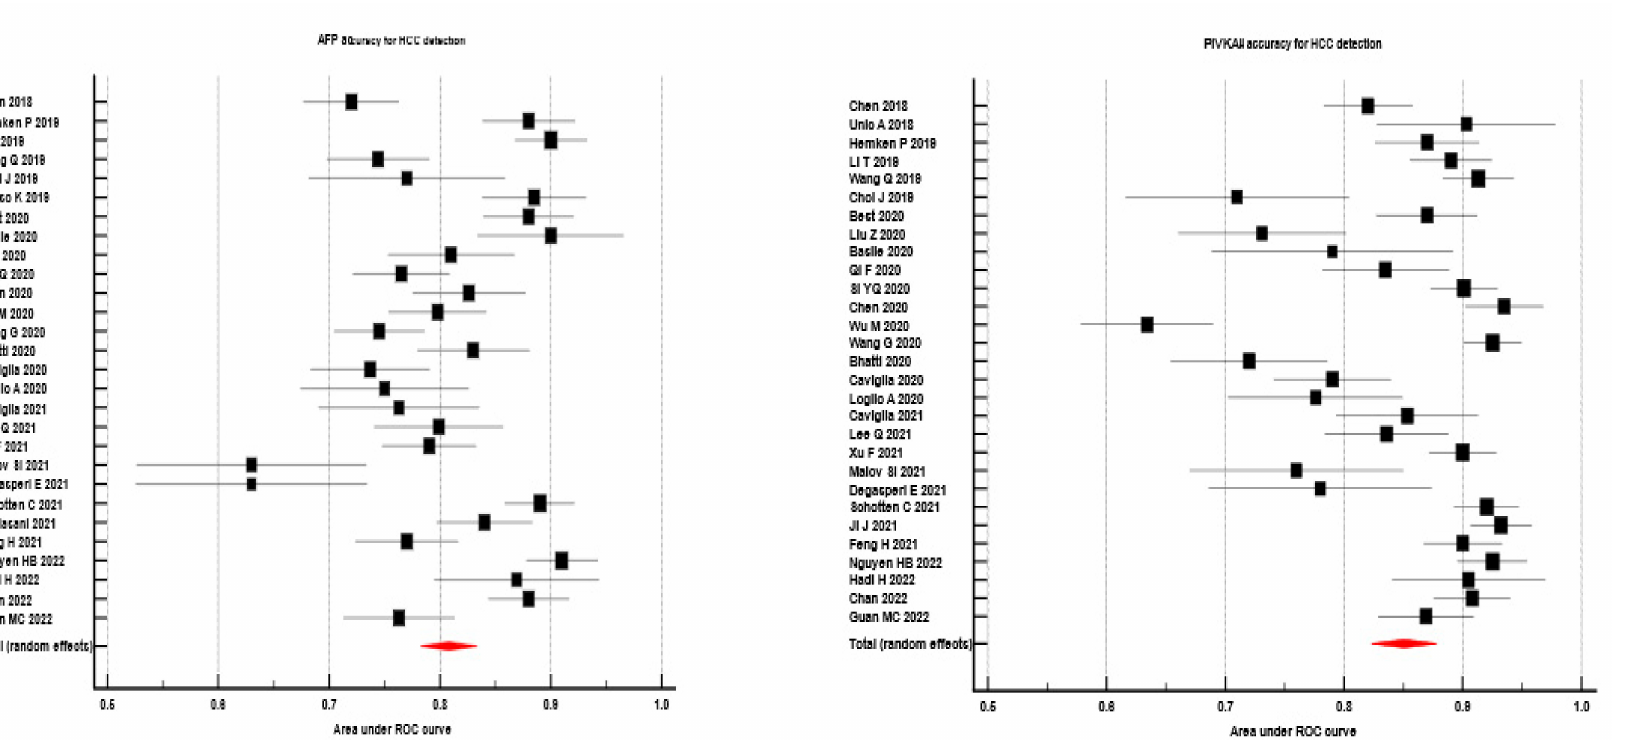
Figure 2. The capacity of AFP vs. PIVKA II to diagnose HCC—global–Forrest plot of AFP vs. PIVKA II accuracy for HCC detection; Left panel of figure-red marker–AUROC for AFP determined by meta-analysis; Right panel of figure-red marker–AUROC for PIVKA II determined by meta-analysis. References